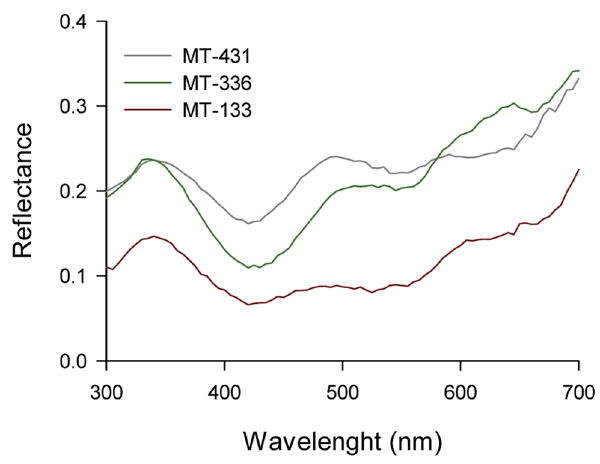
Figure 1. Spectral reflectance curves of the stimuli and background. Spectral reflectance of the grey background (Canson MT-431) and the two coloured stimuli (MT-336 and MT-133) in the 300– 700 nm range.